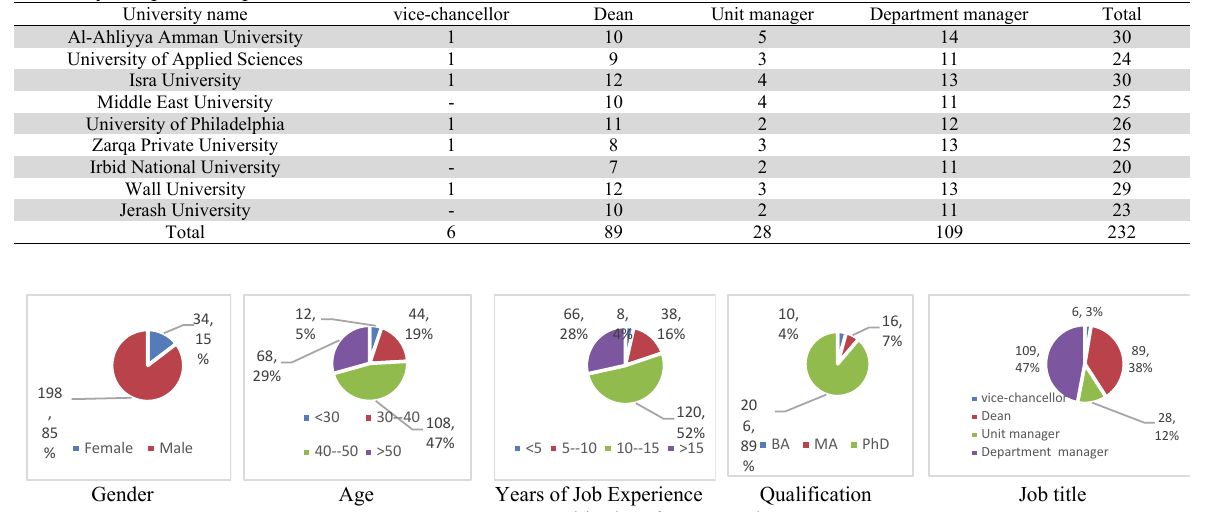
Fig. 2. Demographic data for